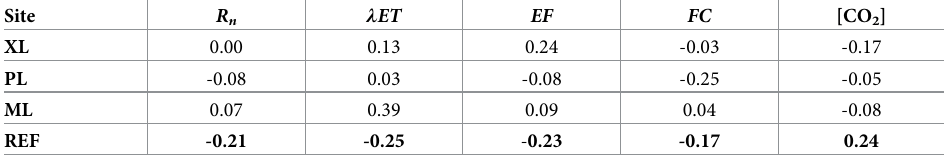
Table 5. Pearson correlation coefficient (CC) of daily values of normalized difference vegetation index with net radiation, latent heat flux, evaporative fraction, carbon dioxide flux and carbon dioxide concentration at all sites for simultaneous periods.